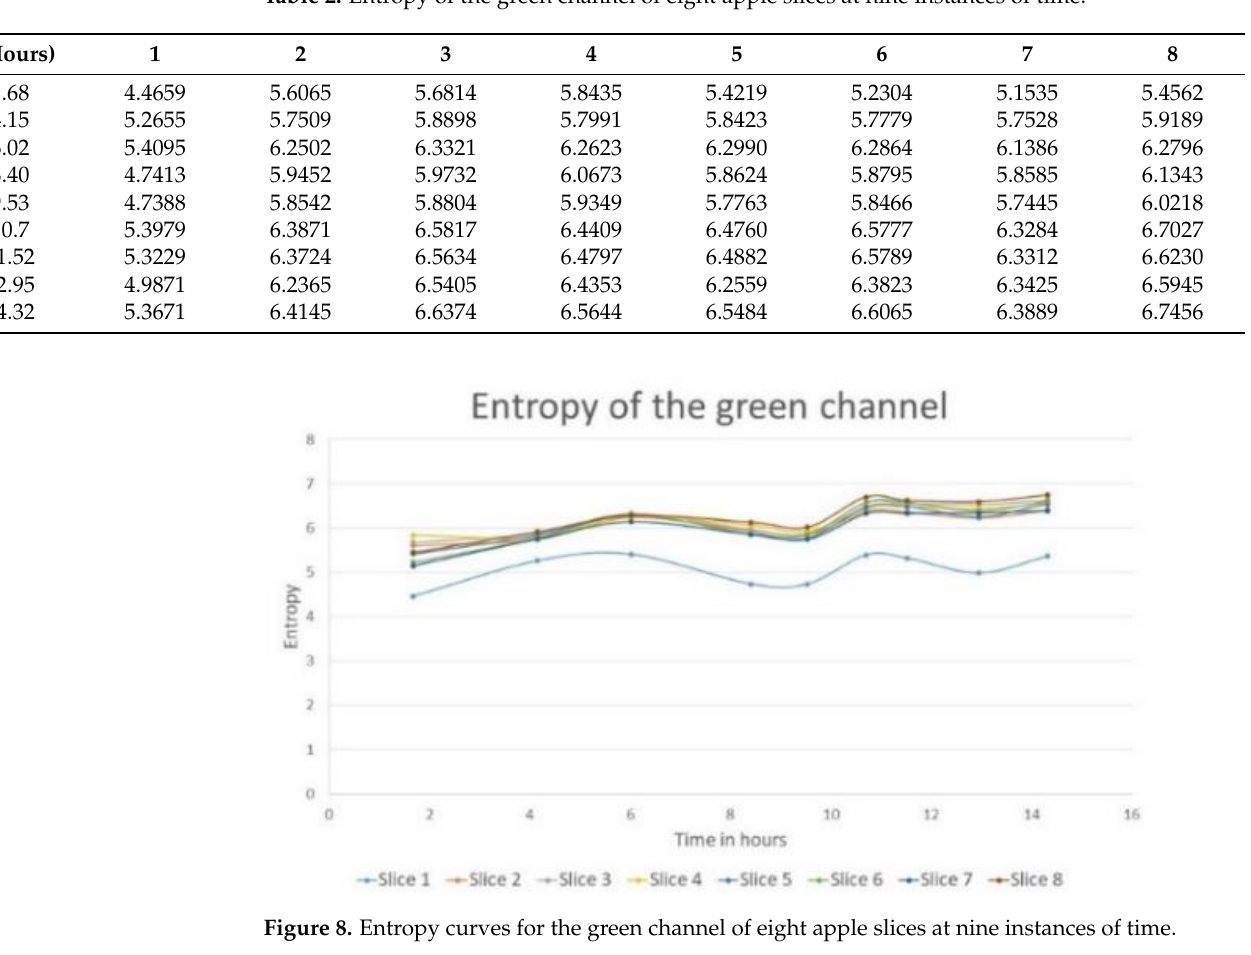
Table 2. Entropy of the green channel of eight apple slices at nine instances of time.